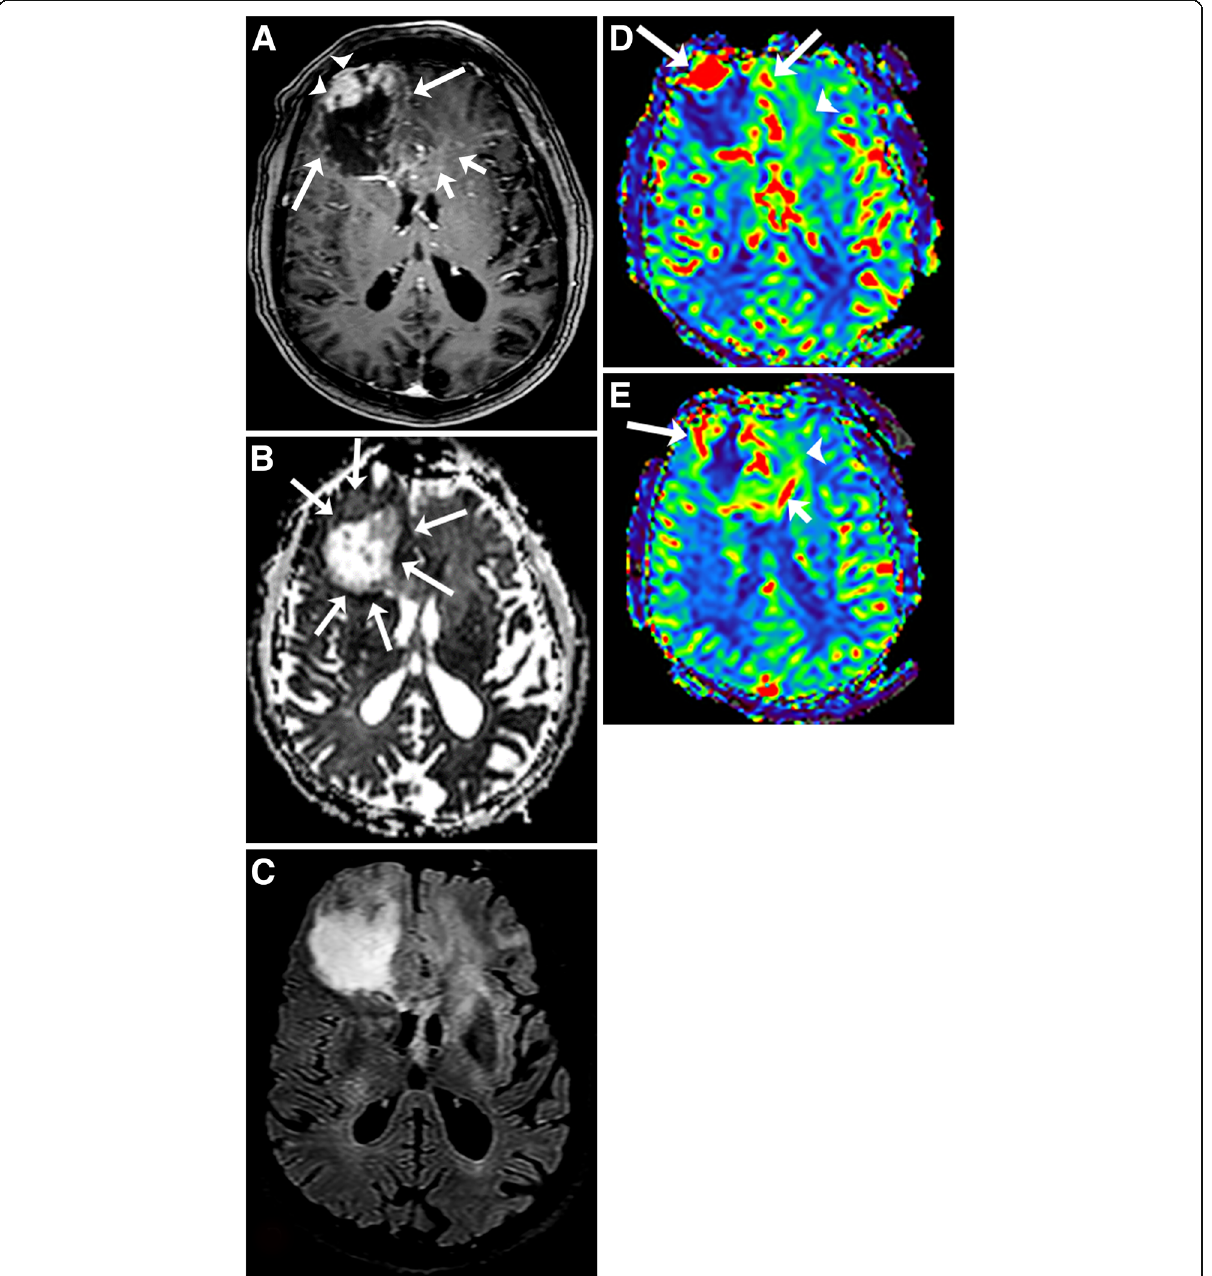
Fig. 8 Glioblastoma. T1-weighted image with gadolinium ( a ) shows an irregular rim-enhancing mass with thick (arrowheads) and thin (long arrows) areas of enhancement in the right frontal lobe. The mass extends into the genu of the corpus callosum and left frontal lobe with minimal irregular enhancement (short arrows). ADC map ( b ) demonstrates predominant elevated ADC within the necrotic mass. The rim of the mass has minimal decreased ADC values (arrows). T2 FLAIR ( c ) shows the necrotic right frontal lobe mass, enlargement of the genu of the corpus callosum and diffuse mild T2 high signal abnormality in the left frontal lobe. On CBV map ( d , e ), there is associated increased perfusion in the rim of the mass (long arrows) in the right frontal lobe, corpus callosum (short arrow), and to a lesser degree in the left frontal lobe